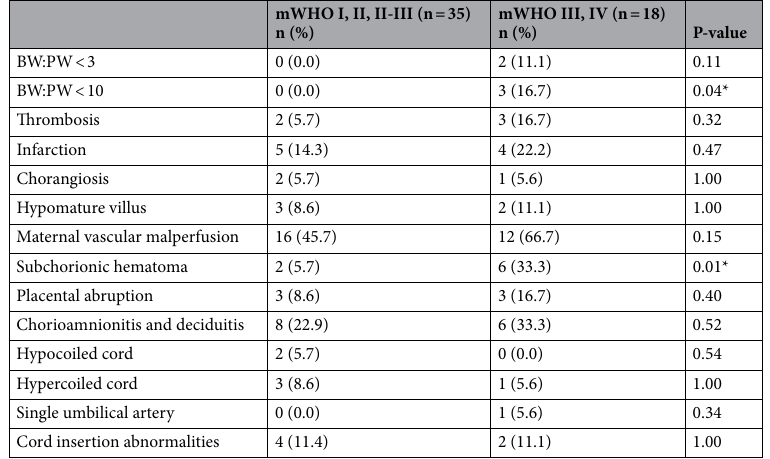
Table 4. Placental histopathological findings in pregnancies by cardiovascular risk using modified WHO classification.